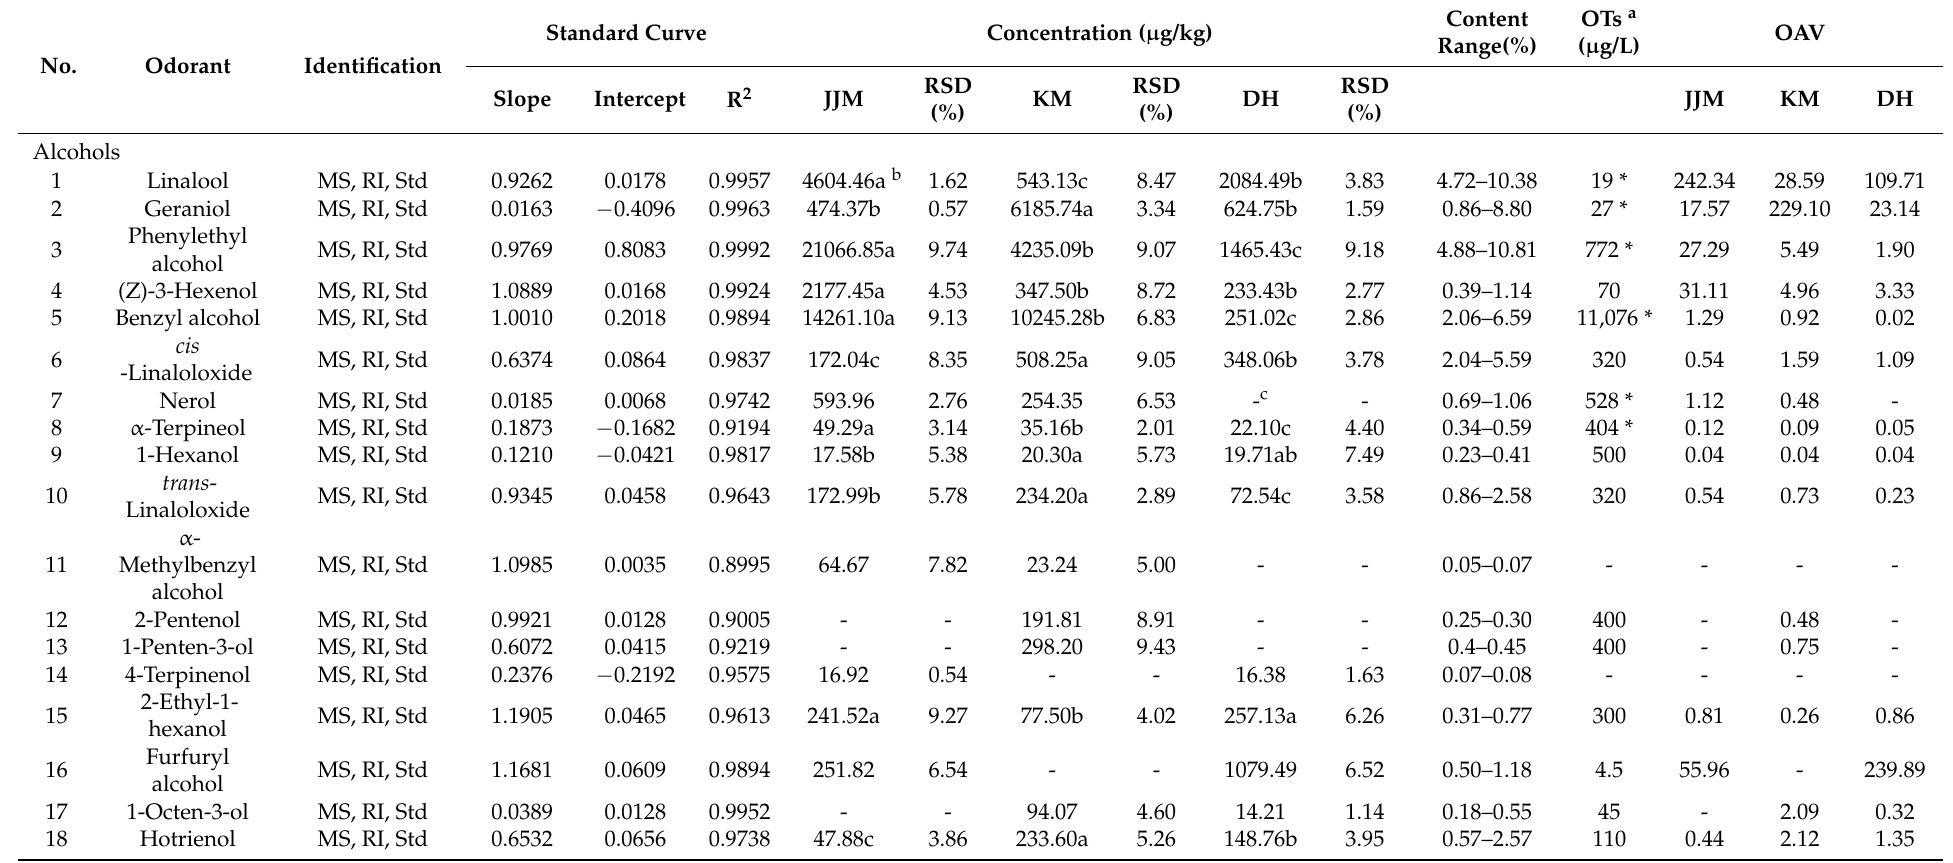
Table 2. Concentrations, odor thresholds and odor activity values (OAVs) of key aroma compounds in Jinjunmei (JJM), Keemun (KM), and Dianhong (DH) black